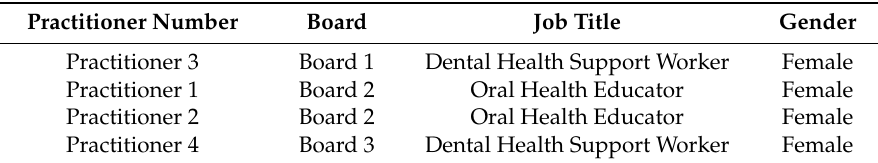
Table 2. Details of participating oral health